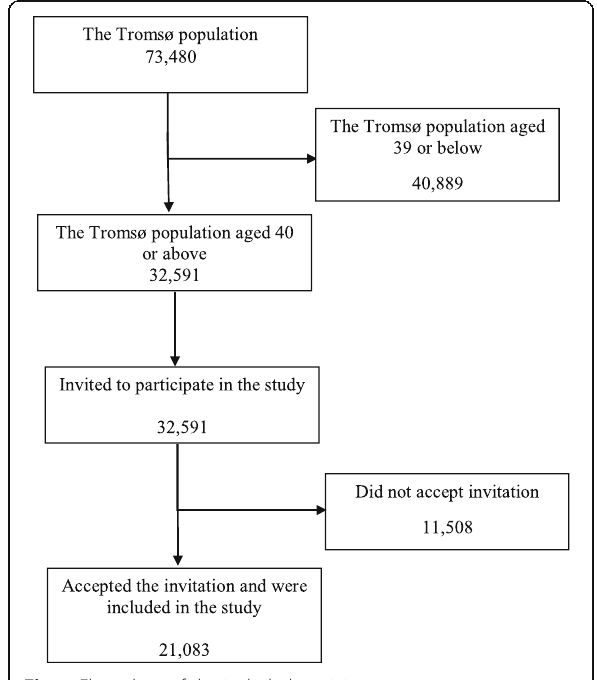
Fig. 1 Flow chart of the included